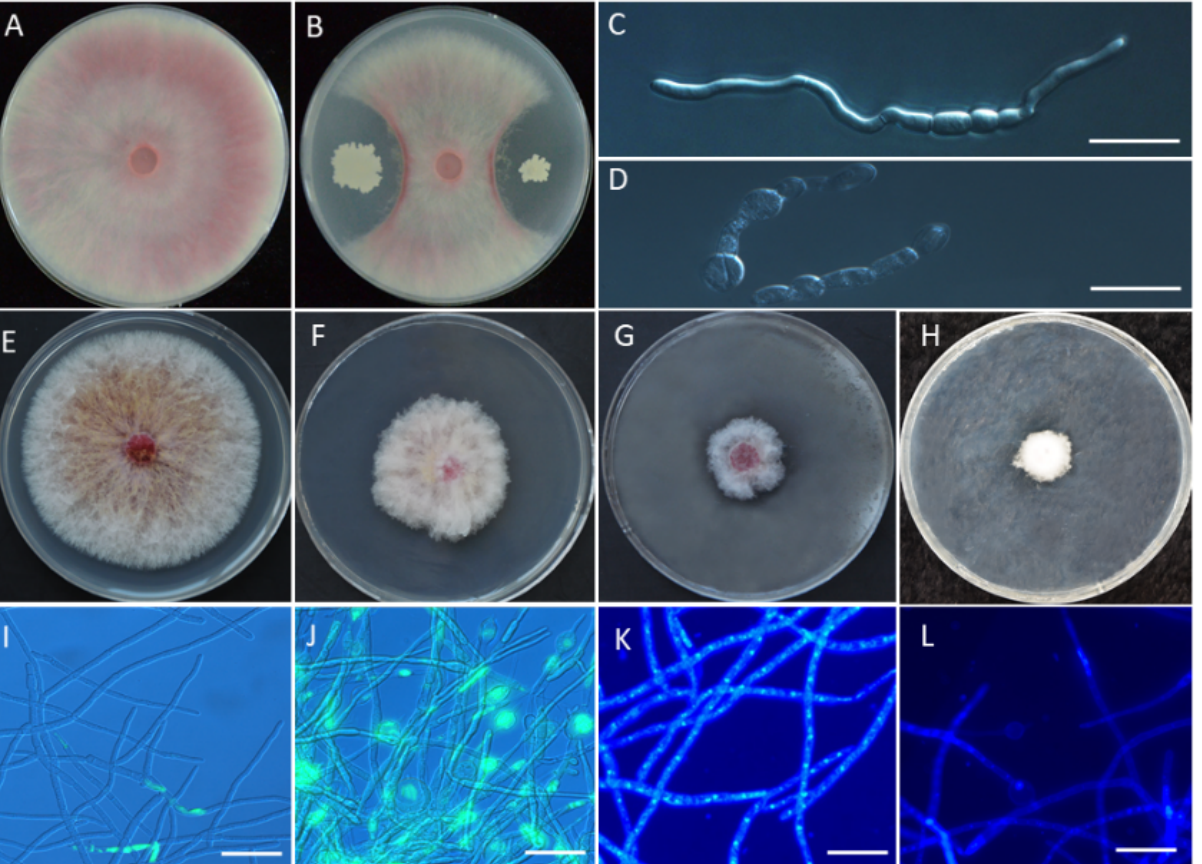
Figure 1. Effect of YB-185 and YB-185 culture filtrate on Fusarium pseudograminearum . ( A ) Pure culture of F. pseudograminearum on PDA; ( B ) dual-culture of F. pseudograminearum and YB-185 on PDA; ( C ) conidial germination of F. pseudograminearum in pure culture at 12 h; ( D ) conidial germination of F. pseudograminearum with 1:5 YB-185 culture filtrate at 12 h; ( E ) mycelia of F. pseudograminearum on PDA; ( F–H ) mycelia of F. pseudograminearum on PDA containing 1:10, 1:5, 1:2 YB-185 culture filtrates, respectively; ( I ) green fluorescence indicating apoptosis by TUNEL staining of F. pseudograminearum on PDA; ( J ) TUNEL staining of F. pseudograminearum on PDA containing 1:5 YB-185 culture filtrate; ( K ), fluorescence indicating nuclear fragmentation by DAPI staining of F. pseudograminearum on PDA; ( L ) DAPI staining of F. pseudograminearum on PDA containing 1:5 YB- 185 culture filtrate. Bar = 10 μ m.